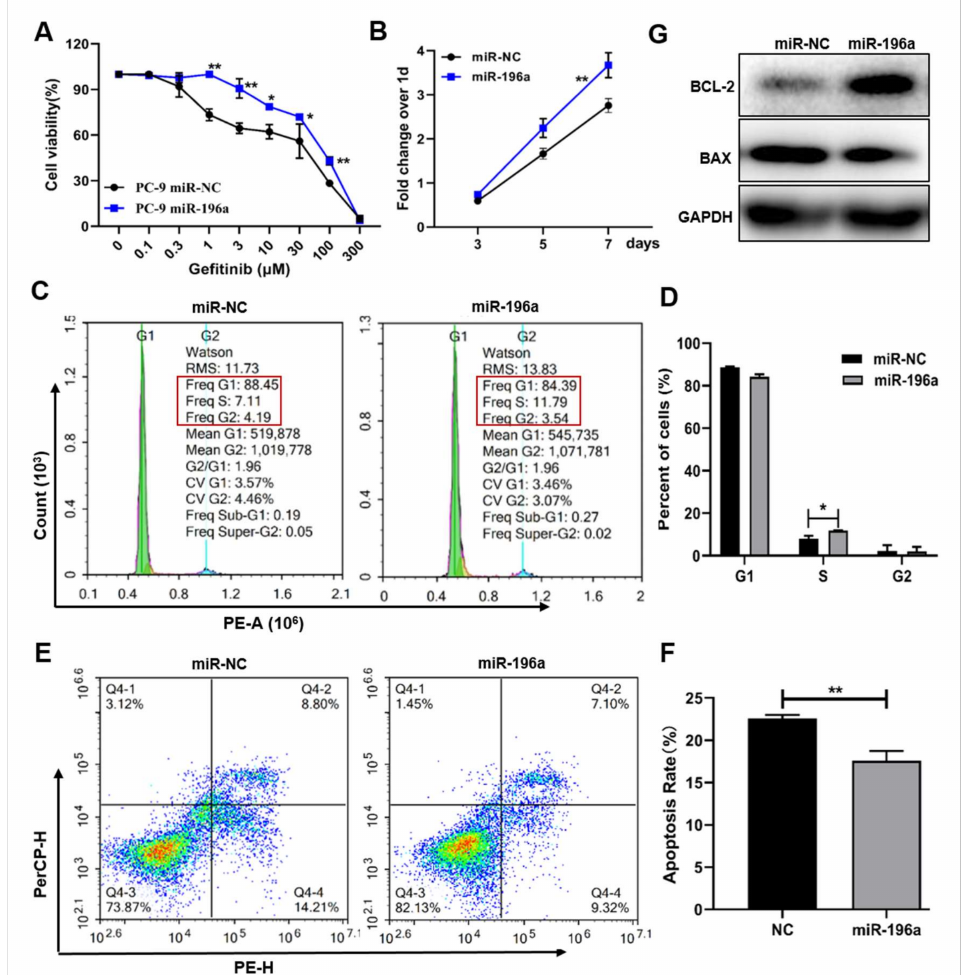
Figure 2. Forced expression of miR-196a-induced gefitinib resistance by promoting cell proliferation and inhibiting apoptosis. We constructed a stable overexpression cell line of miR-196a in PC-9 cells and treated them with 1 µ M gefitinib for 48 h. ( A ) The cell viability following a 48-h exposure to different concentrations of gefitinib was determined in PC-9-NC and PC-9-miR-196a cells by Cell Counting kit-8 (CCK8) assay. ( B ) Cell proliferation ability was measured using the CCK8 assay as described in the methods. ( C ) Cell cycle was detected by flow cytometry analysis in PC-9 cells treated with gefitinib. ( D ) Quantitative analysis was investigated with different stages of cell cycles from three independent experiments. ( E ) Cell apoptosis was performed with flow cytometry according to the manufacturer’s protocol. ( F ) Percentage of cell apoptosis cells as shown in ( E ). ( G ) The protein expression levels of apoptosis relative protein BCL-2 and BAX by Western blotting. Data represent the mean ± S.D. of 3 independent experiments where * indicates significant difference at p < 0.05, ** at p <